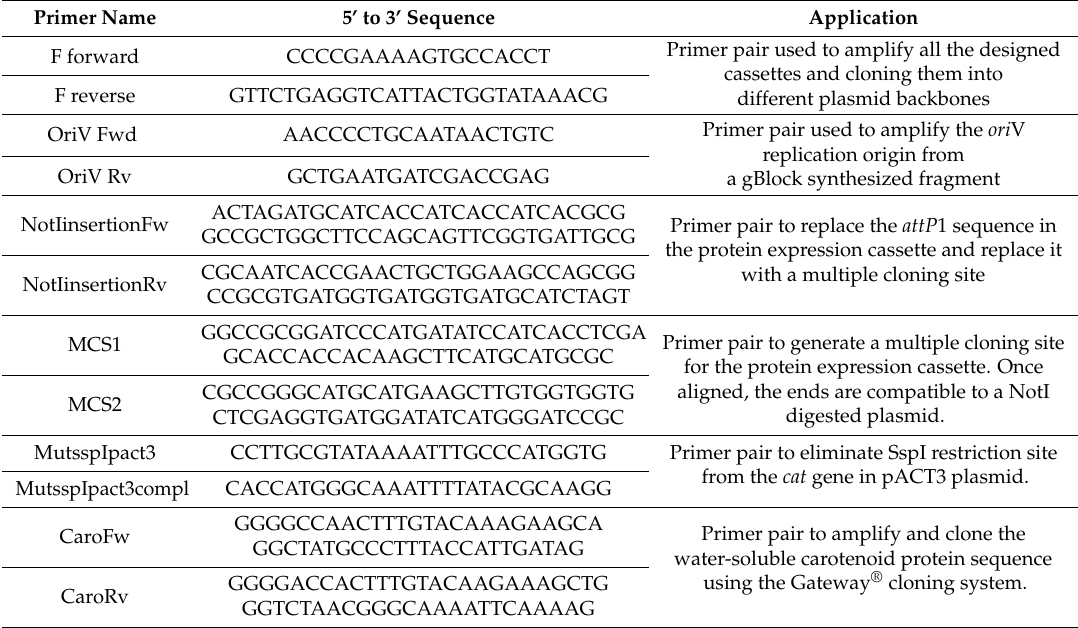
Table 3. Oligonucleotides used in this